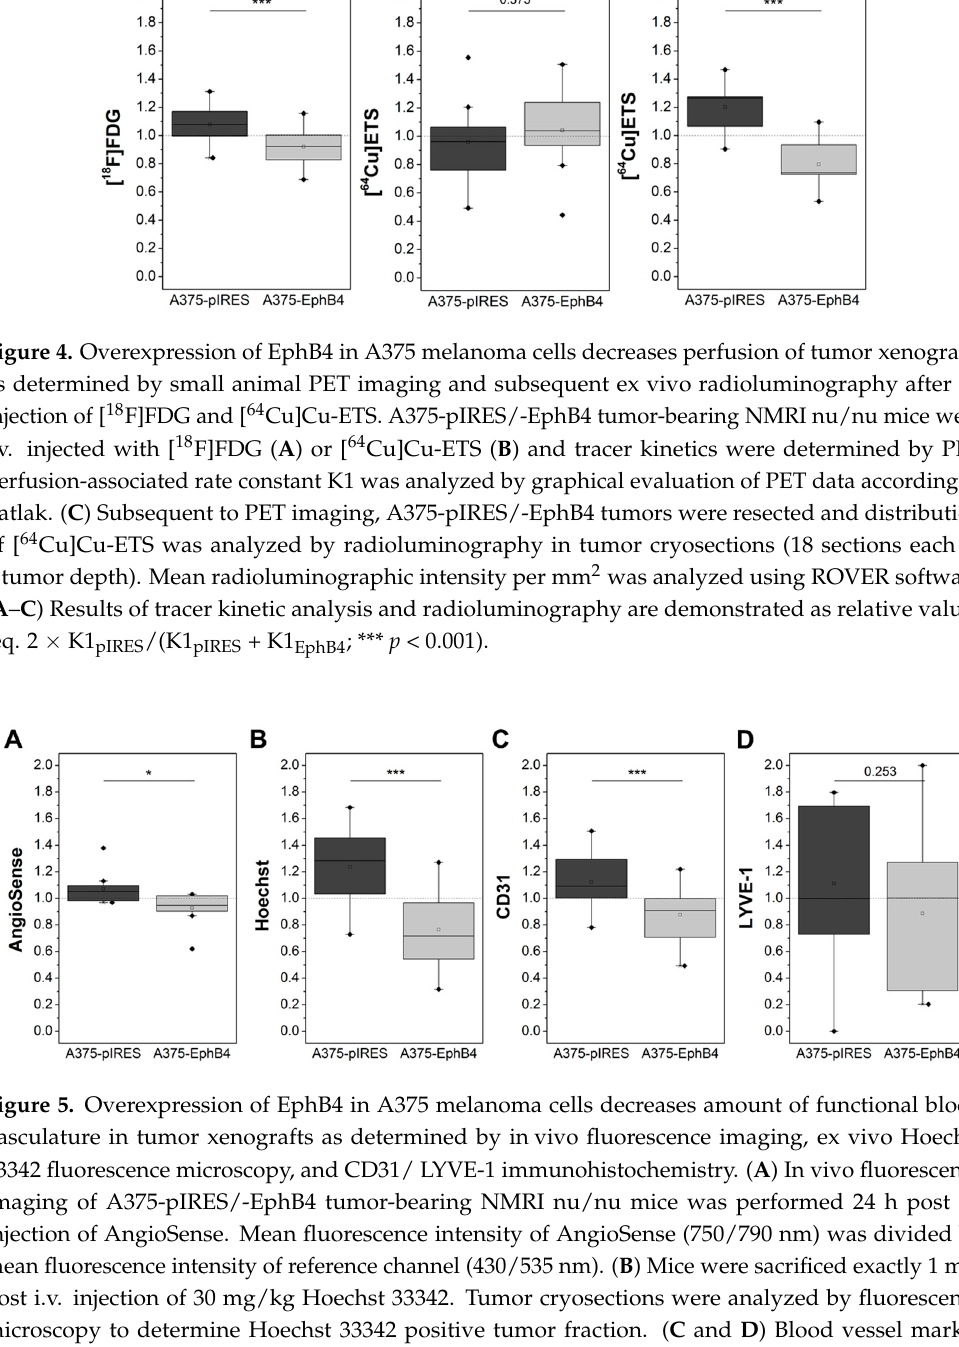
6 of 21 Figure 3. Representative images of PET, radioluminography, in vivo fluorescence imaging, and ex vivo (fluorescence) microscopy of A375-pIRES/-EphB4 tumor-bearing NMRI nu/nu mice and tumor cryosections. After intravenous injection [ 18 F]FDG, [ 64 Cu]Cu-ETS, and [ 18 F]FMISO clearly accumulate in A375-pIRES and A375-EphB4 tumors and can be visualized by small animal PET ( A – C ) and subsequent radioluminography ( D – F ). ( A – C ) PET data are illustrated as maximum intensity projection (MIPs) of tracer-dependent frame times ([ 18 F]FDG, 30–60 min p.i.; [ 64 Cu]Cu-ETS, 0–30 min p.i.; [ 18 F]FMISO, 180–240 min p.i.). ( D – F ) Subsequent to PET imaging, A375-pIRES/-EphB4 tumors were resected and distribution of PET tracers was analyzed by radioluminography in tumor cryosections (18 sections each in 3 tumor depth). ( G ) In vivo fluorescence imaging of A375-pIRES/- EphB4 tumor-bearing NMRI nu/nu mice 24 h post i.v. injection of AngioSense (750/790 nm). ( H ) Ex vivo fluorescence microscopy of A375-pIRES/-EphB4 tumor cryosections following i.v. injection of 30 mg/kg Hoechst 33342 exactly 1 min before sacrifice of mice. ( I ) Tumor cryosections were stained with CD31 and LYVE-1 specific primary antibodies as well as Alexa Fluor 488- and Alexa 546-conjugated